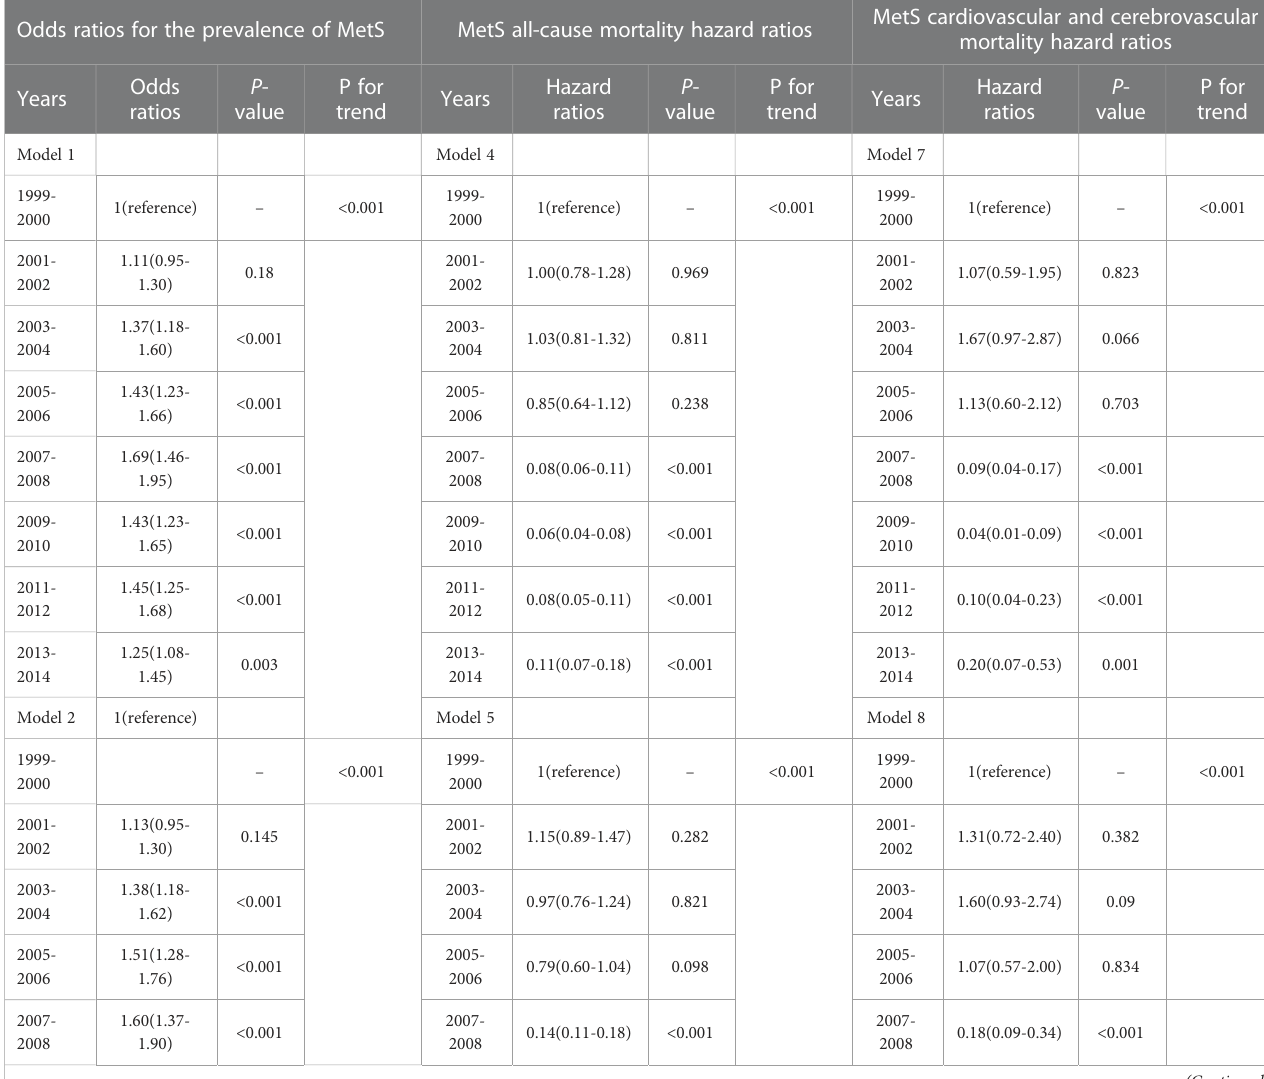
TABLE 2 Odds ratios for prevalence and hazard ratios for all-cause, cardiovascular, and cerebrovascular mortality from 1999-2002 to 2011-2014. Odds ratios for the prevalence of MetS MetS all-cause mortality hazard ratios